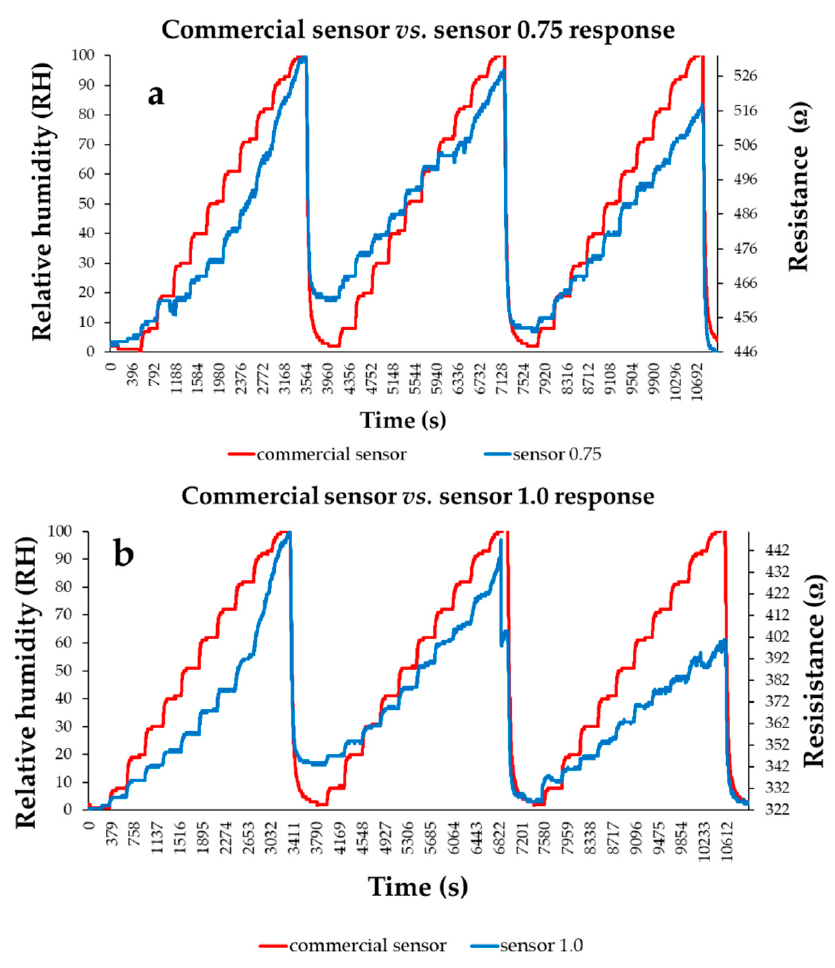
Figure 8. The response of ( a ) Sensor 0.75 and ( b ) Sensor 1.0. “R curve-blue” presented as a function of time for three measurement cycles when relative humidity was increased in ten steps from 0% RH to 100% RH; “RH curve-red” shows similar characteristic measured for a commercial, capacitive sensor. The resistance of the organic-inorganic quaternary hybrid-based thin film increases when RH increases. It is observed that the resistance of the sensing layer for the RH value “0” is growing with the decrease of the CNHox (nanocarbonic materials with high conductivity) content in the nanohybrid. The quaternary nanohybrid-based resistive sensors’ overall linearity—in humid nitrogen when varying RH from 0% to 100%—is excellent, as shown in Figure 9. In terms of linearity, the sensor 0.75 seems to have